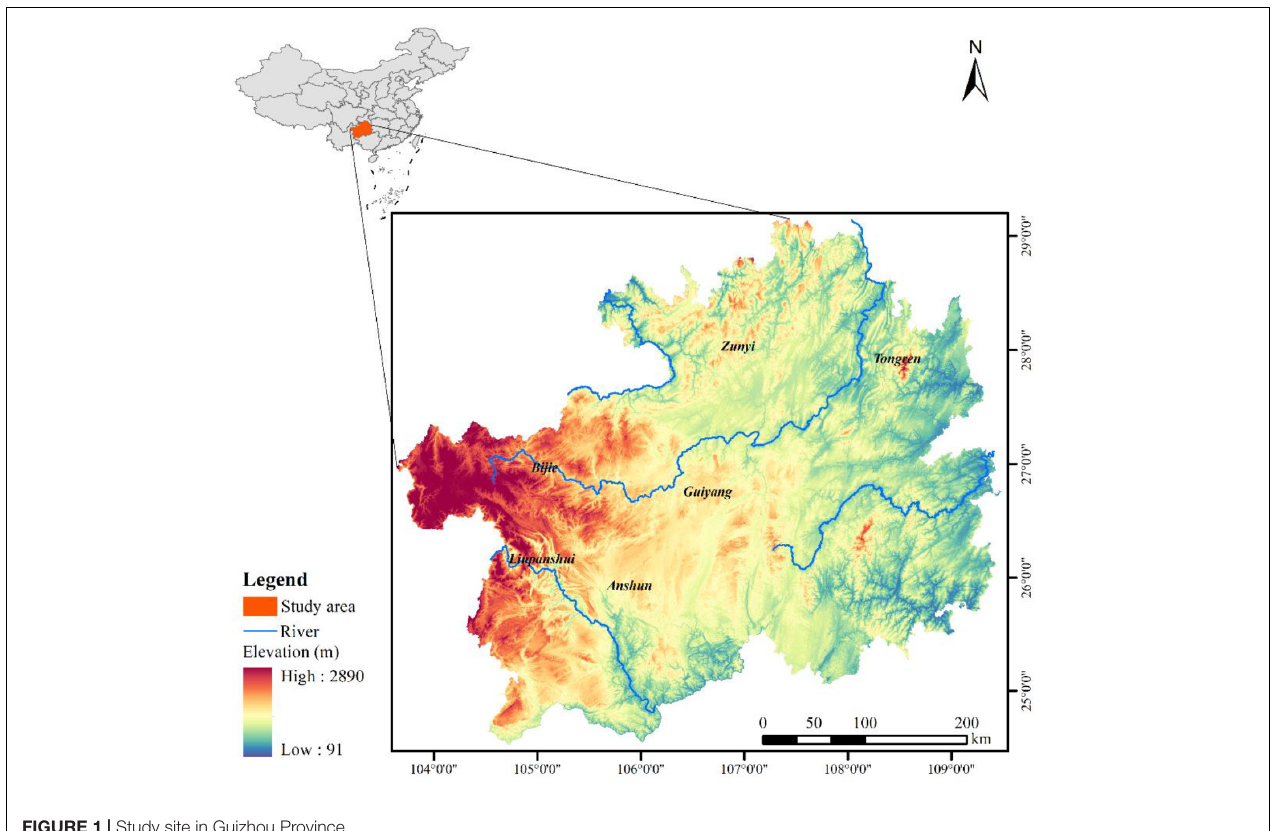
FIGURE 1 | Study site in Guizhou Province.